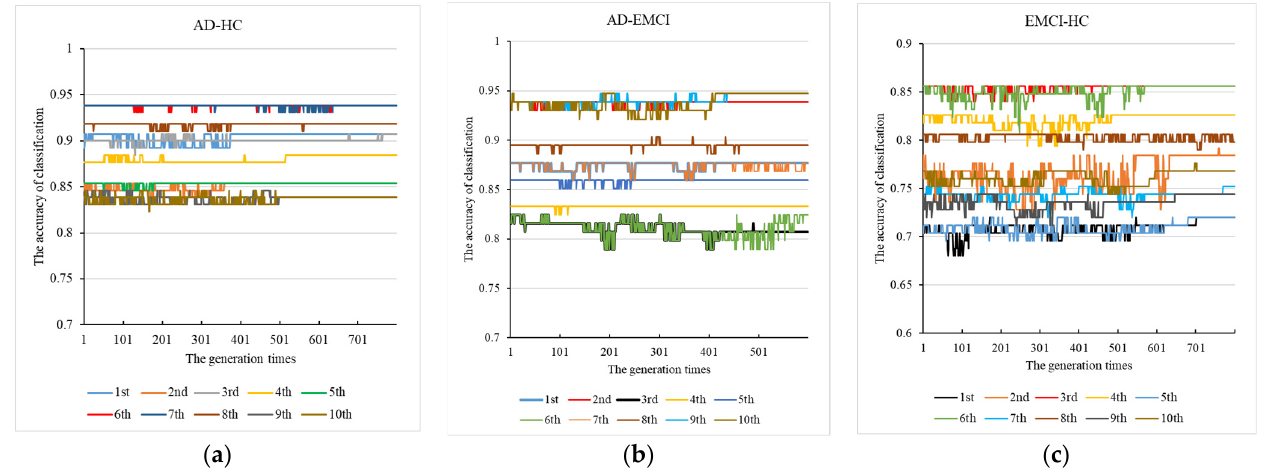
Figure 3. The 10 independent repeat experiments with ( a ) AD-HC, ( b ) AD-EMCI and ( c ) EMCI-HC.